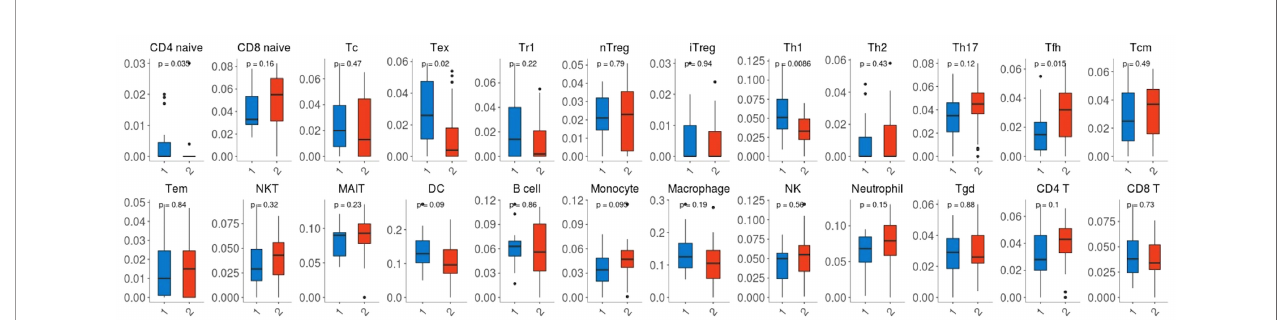
FIGURE 6 | Comparison between the fractions of immune cells in the responder (R) and non-responder (NR) subgroup of the GSE45404 cohort via the